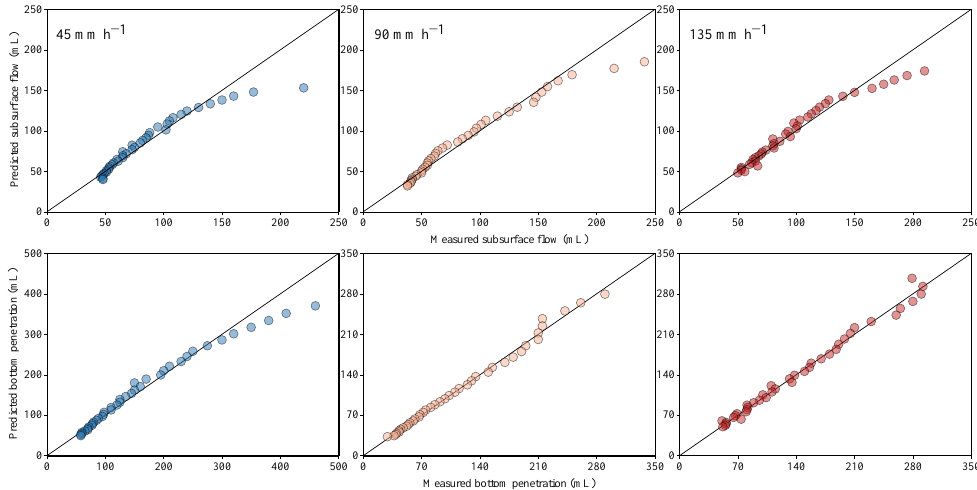
Figure 12. Relationships between the measured and predicted subsurface flow and bottom penetra- tion after rainfall